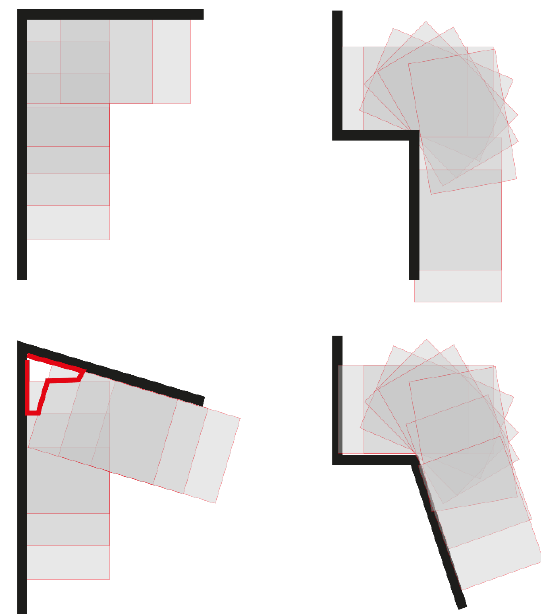
Figure 7. different behaviour of the prototype in the acquisition of convex and concave corners. The most complex is the case of convex corner (bottom left) where the size of the cart doesn’t allow to reach each part of the corner.